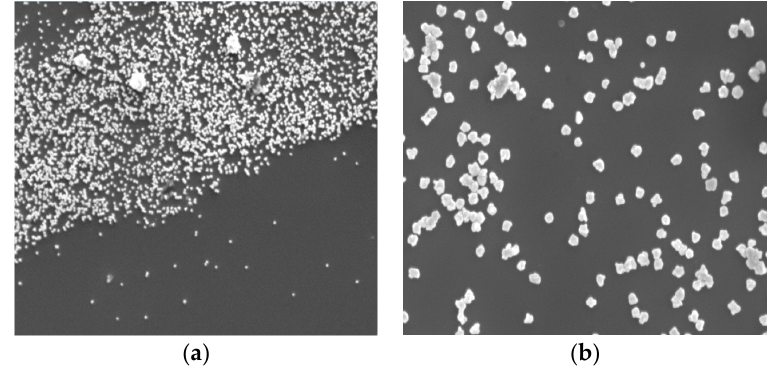
Figure 9. FE-SEM images of ( a ) targeted spot on array after gold enhancement process (scale bar = 4 µm) ( b ) Higher magnification of the spot (scale bar = 500 nm). ( b ) Higher magnification of the spot (scale bar = 500